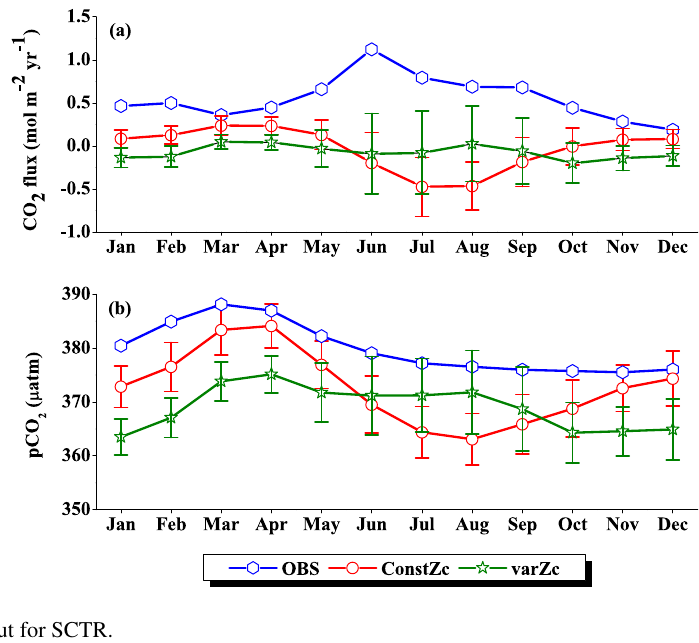
Figure 14. Same as Fig. (6), but for SCTR.